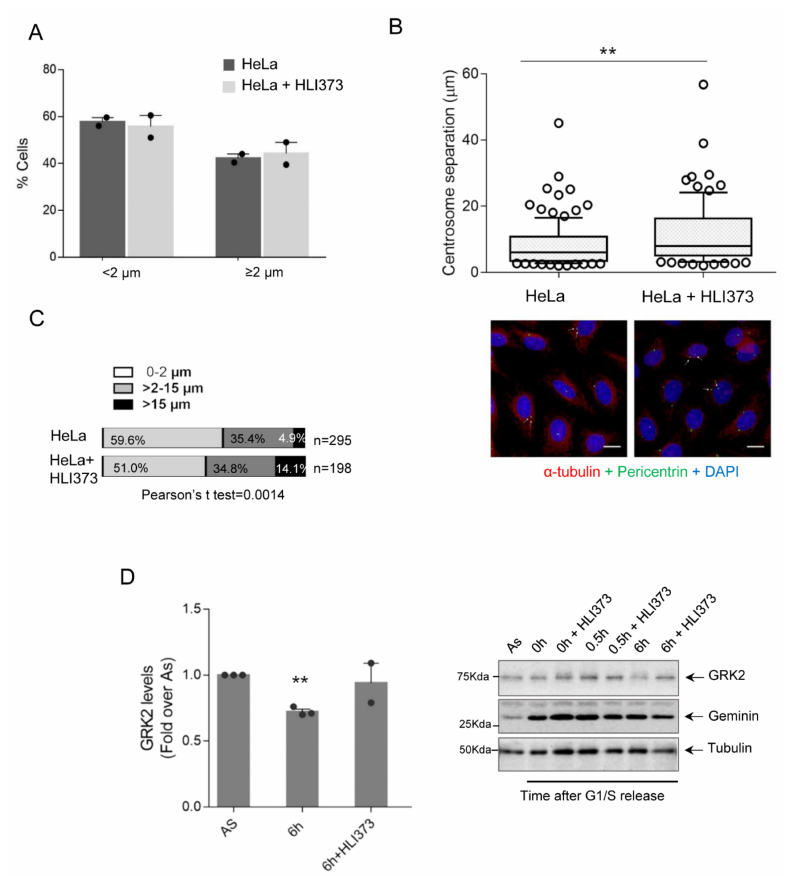
Figure 4. Inhibition of Mdm2-dependent GRK2 degradation in the G2 correlates with enhanced EGF-induced centrosome separation. HeLa cells were synchronized at G1/S transition with a thymidine-aphidicolin double block and released into the cell cycle for 6 h in the presence of 100 ng/mL EGF with or without the Mdm2 inhibitor HLI373 (3 µ M). Cells were fixed and co-stained with anti-pericentrin (green) and anti- α -tubulin (red) antibodies in combination with DAPI (blue) for DNA detection. Distance between two duplicated centrosomes was quantified. ( A ) Percentage of cells with separated ( ≥ 2 µ m) and non-separated (<2 µ m) centrosomes. Data are means ± SEM from 2 independent experiments with n > 200 cells per condition in each experiment. ( B ) Inter-centrosomal distances in cells with separated centrosomes in control or HLI373-treated conditions under EGF stimulation. Data are means ± SEM depicted in a box-and-whisker plot (mean: control = 6.1 µ m, n = 115; HLI373 = 8.0 µ m, n = 97). Confocal images of representative cells are shown. Scale bar, 10 µ m. ** p < 0.01, Mann–Whitney test. ( C ) Percentage of cell distribution according to non-separated duplicated centrosomes (0–2 µ m), centrosomes with separation between 2 and 15 µ m and centrosomes separated with larger distance (>15 µ m). ( D ) Effect of HLI373 treatment on GRK2 levels. Immunoblots of RIPA lysates from control and HLI373-treated cells in the presence of EGF stimulation and progressing into the G2 for the indicated times after G1/S release were assessed for GRK2 and anti-tubulin as control of protein loading. Geminin levels confirm comparable synchronization in both cellular conditions. ** p < 0.01, two-tailed t -test. A representative blot is shown. Detailed information about the Western blots can be found in Figure